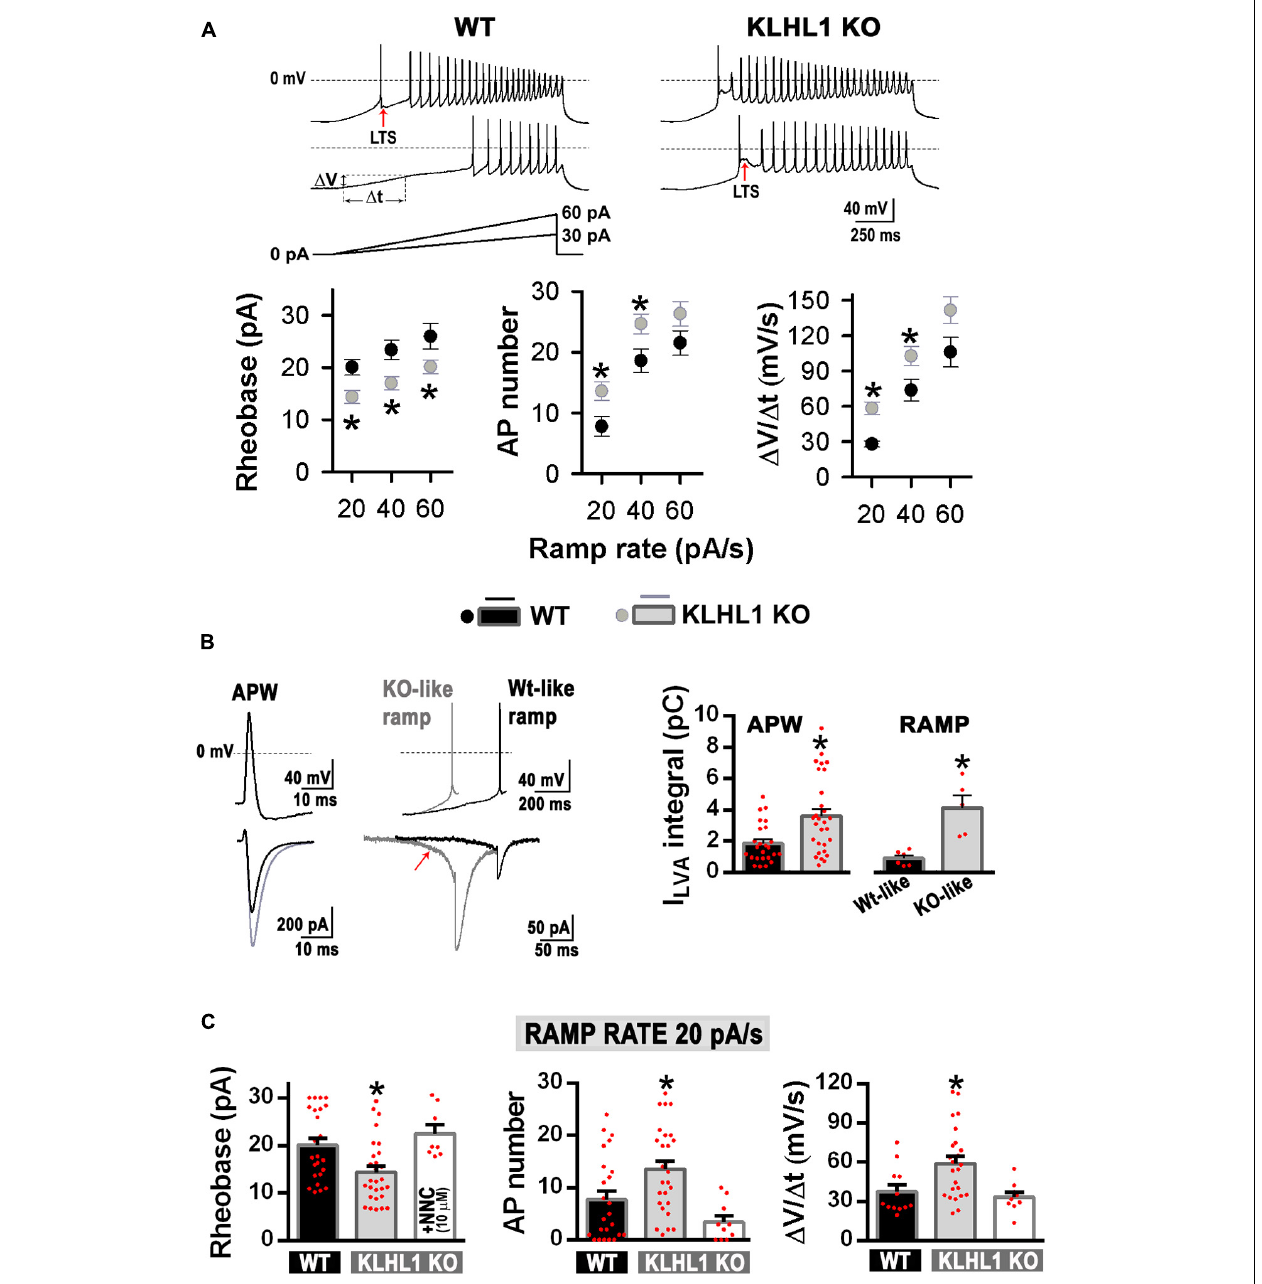
FIGURE 5 | Increased membrane excitability in KLHL1-KO neurons. (A) Top: Examples of neuronal firing elicited from V H = –75 mV by a 20 and 40 pA/s ramps in WT and KLHL1-KO neurons. Red arrows indicate low-threshold spike (LTS) responses. Bottom: Rheobase (pA), number of action potentials and rate of membrane potential depolarization (Slope = (cid:49) V/ (cid:49) t , mV/s, see panel A in response to 20, 40 and 60 pA/s ramps) in WT ( n = 24, 24, 12) and KLHL1-KO ( n = 28, 28, 24) neurons. * P < 0.05, t -test. Rheobase: t = 2.924 for 20 pA/s, t = 3.107 for 40 pA/s, t = 2.155 for 60 pA/s, df = 50. AP number: t = 2.607 for 20 pA/s, t = 2.428 for 40 pA/s, df = 50. Slope: t = 2.481 for 20 pA/s, t = 2.108 for 40 pA/s, df = 34. (B) Left: Average traces of T-type LVA currents elicited by an action potential waveform ( (cid:49) V/ (cid:49) t = 0 mV/s, APW protocol). Center: Isolated LVA component traces elicited by action potentials preceded by a slope and a rheobase representative of either WT (WT-like ramp, (cid:49) V/ (cid:49) t = 30 mV/s, rheobase = 20 pA) or KLHL1-KO neurons (KO-like ramp, (cid:49) V/ (cid:49) t = 60 mV/s, rheobase = 14 pA). The KO-like ramp protocol favors T-type channel recruitment (red arrow). Right: Average LVA current integral in WT and KLHL1-KO neurons. * P < 0.05, t -test. APW protocol: t = 3.241 (df = 52, n = 25 for WT, n = 29 for KLHL1 KO). WT- or KO-like ramp protocols: t = 4.372 (df = 9, n = 6 for WT, n = 5 for KLHL1 KO). (C) Quantification of rheobase (pA), number of action potentials and rate of membrane potential depolarization (Slope = (cid:49) V/ (cid:49) t , mV/s) in WT ( n = 24, 24, 12), KLHL1-KO ( n = 28, 28, 24) and NNC 55-0396 (10 µ M)-treated KLHL1-KO ( n = 8, 10, 9) neurons in response to 20 pA/s ramps. *Significantly different from WT and NNC-treated KLHL1-KO neurons. P < 0.05, ANOVA. Rheobase: F 2 , 57 = 6.743, AP number: F 2 , 59 = 8.004, Slope: F 2 , 42 =